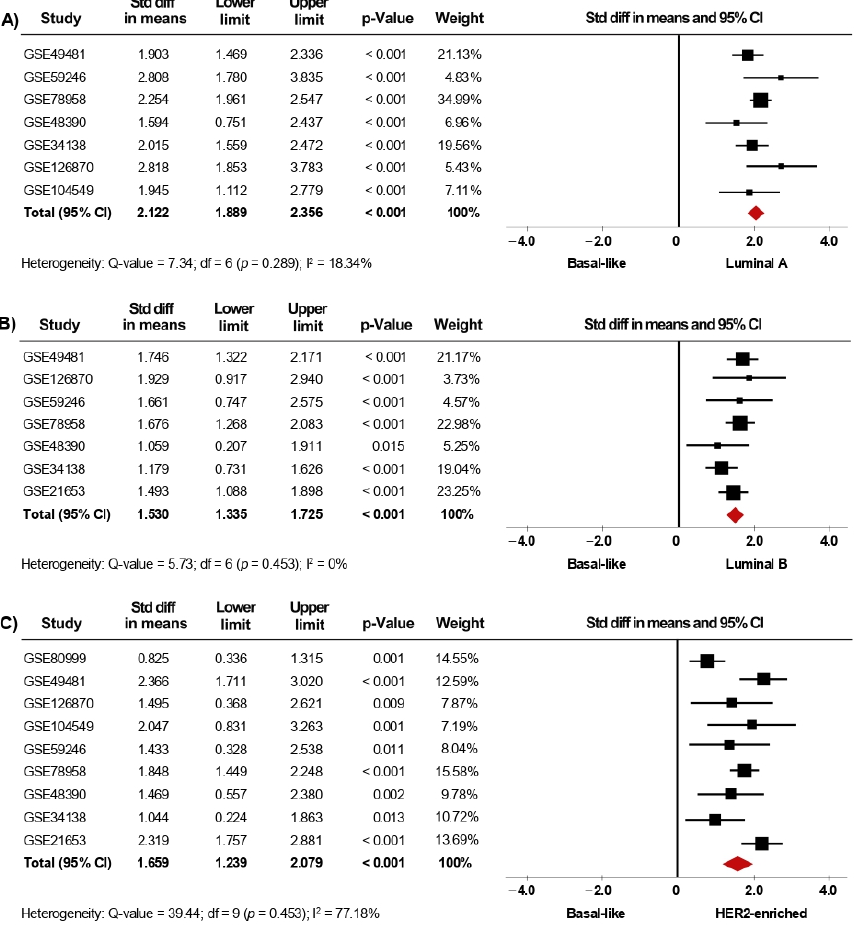
Figure 4. AR mRNA level is significantly increased in patients categorized within the less aggressive intrinsic molecular subtypes. Results after sensitivity analyses. Forest plots of SMD comparing AR mRNA levels in BC patients classified as Basal-like subtype vs. Luminal A ( A ), Luminal B ( B ), and HER2-enriched subtypes ( C ). The squares represent the SMD for each dataset. The horizontal line crossing the square represents the 95% CI. The red diamonds represent the estimated overall